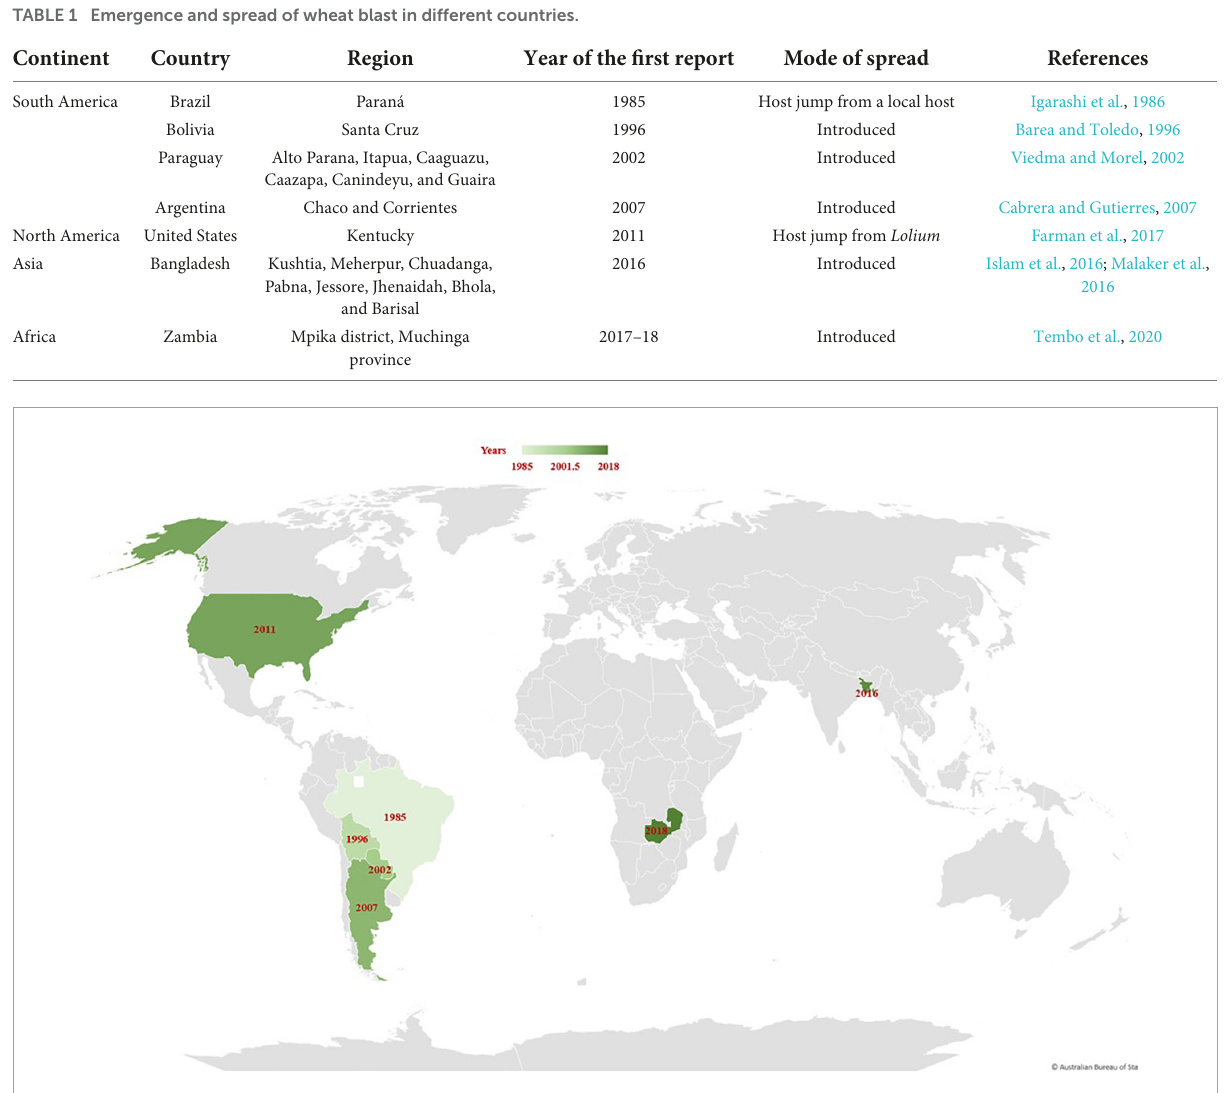
FIGURE1 A map depicting the global appearance and spread of wheat blast over